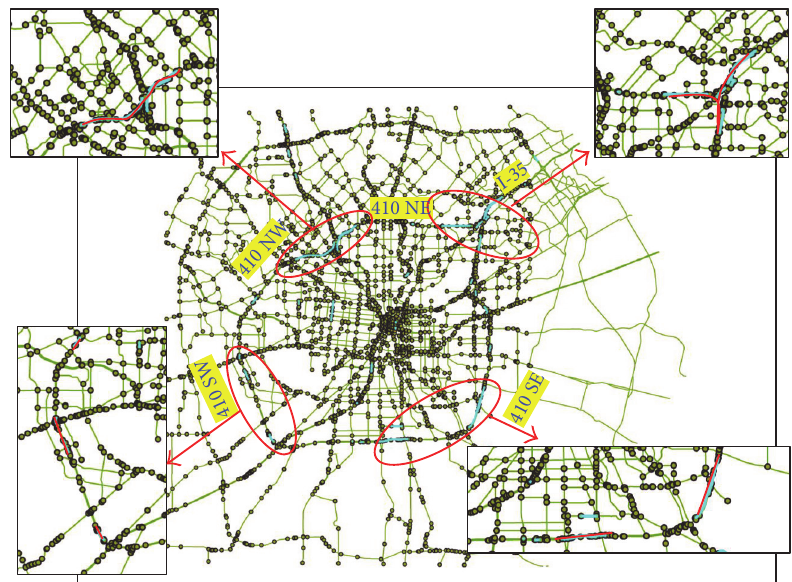
Figure 5: Corridors selected by proposed method for reducing lane and shoulder width (marked in red in zoomed-in parts) in San Antonio city